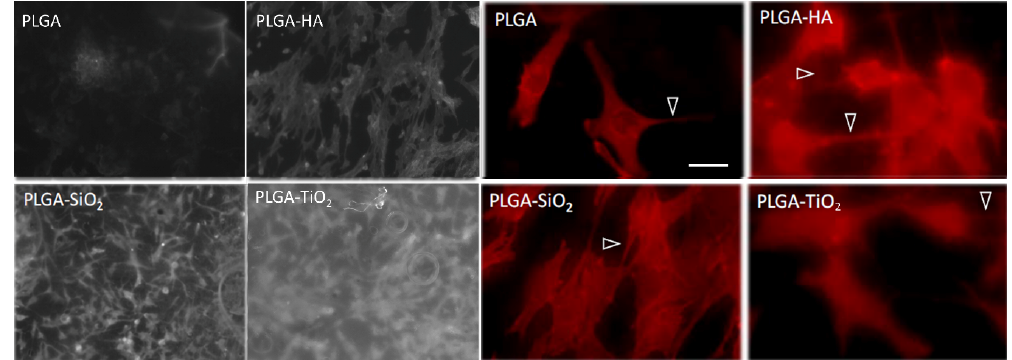
Figure 1. Microphotography of the osteoblasts on the membranes of PLGA, PLGA-HA, PLGA-SiO 2 , and PLGA-TiO 2 . Previously, the cells were fixed with 70% ethanol for five minutes, since without fixation it was not possible to observe them. Images taken at 5 × with the fluorescence microscope Axio Observer A1 (Carl Zeiss). Bar in PLGA = 10 microns (same scale for all images). Filopodia are indicated with